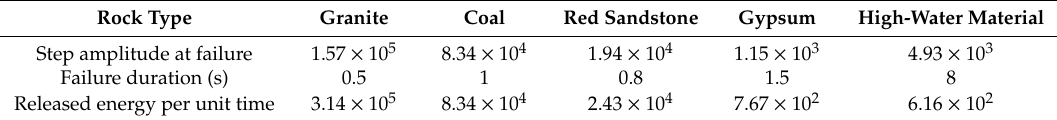
Table 5. The failure duration and the step amplitude at the failure stage for five rock